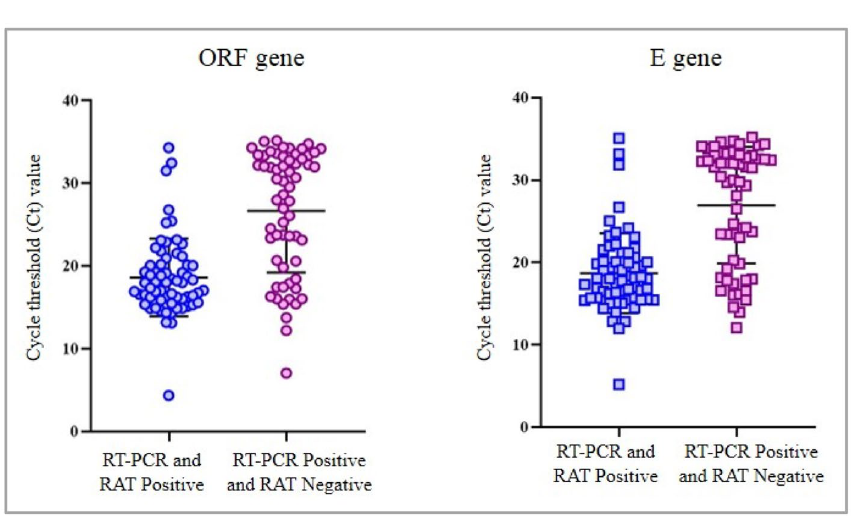
Figure 2. Cycle threshold values in Rapid Antigen Test positive and negative samples. RAT: Rapid Antigen Test; RT-PCR: Reverse Transcriptase-Polymerase Chain